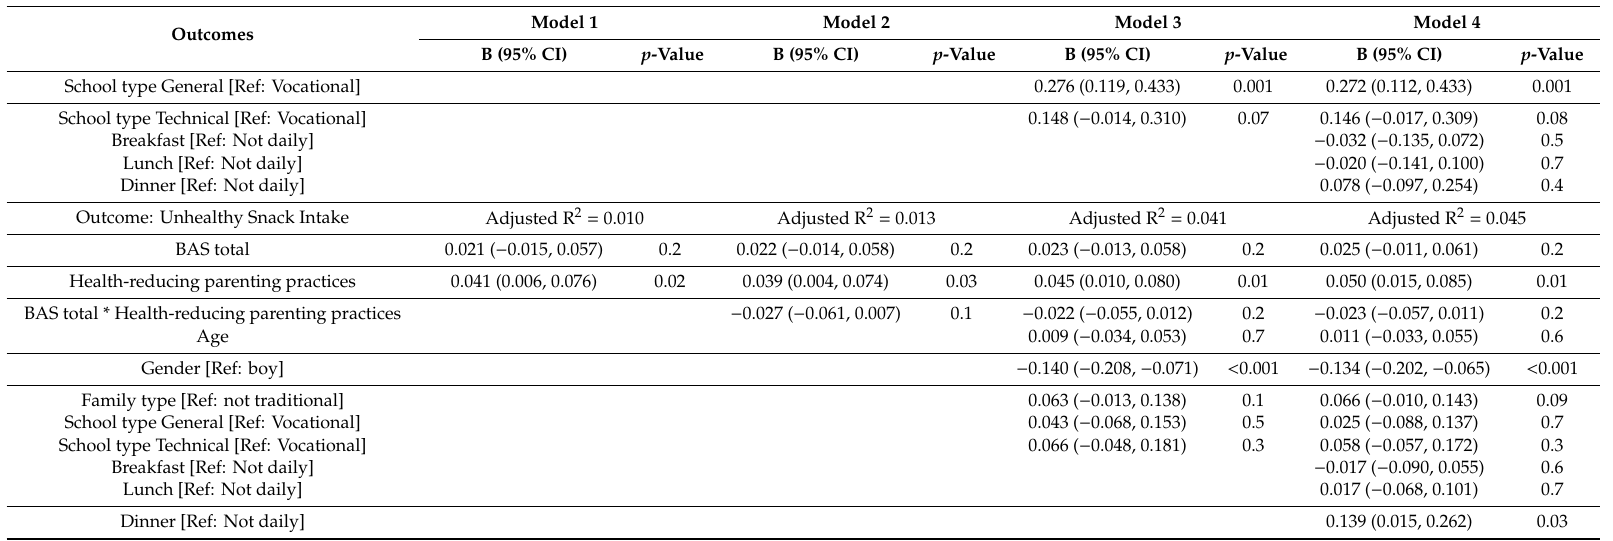
* Results in the table are for complete cases but excluding outliers for diet > 3 SD ( n = 560); Model 1 includes the main independent variables (BAS total, Health-reducing parenting practices); Model 2 includes the main independent variables (BAS total, Health-promoting parenting practices) and the interaction term; Model 3 includes adjustments for age, gender, family type (traditional versus other), and school type (general, technical, vocational); Model 4 includes model 3 adjustments plus additional adjustment for breakfast, lunch, and dinner patterns. # BAS total (Behavioral Activation System) is an indicator of Reward sensitivity. Table A5. Associations between reward sensitivity and adolescents’ intake of sugar-sweetened beverages, healthy and unhealthy snack, and the moderating role of (parent-reported) health-promoting parenting practices ( n =